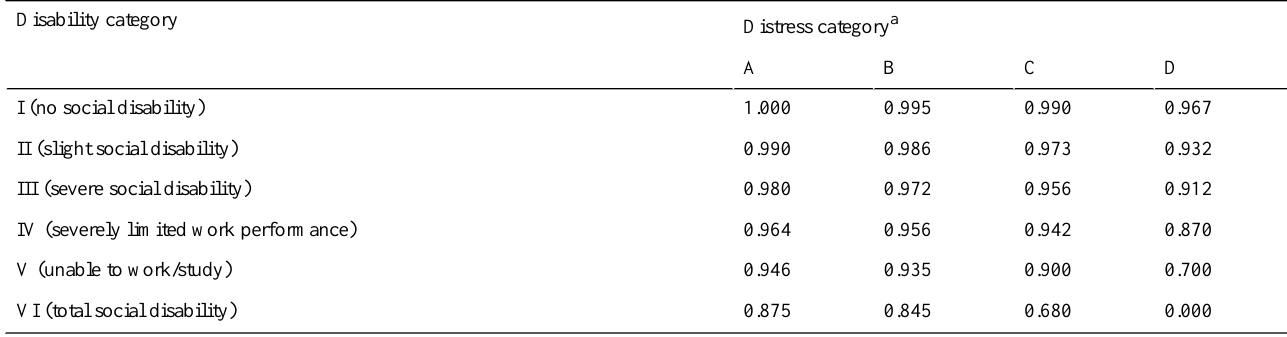
Table 5. Rosser´s utility valuation scores for health conditions.